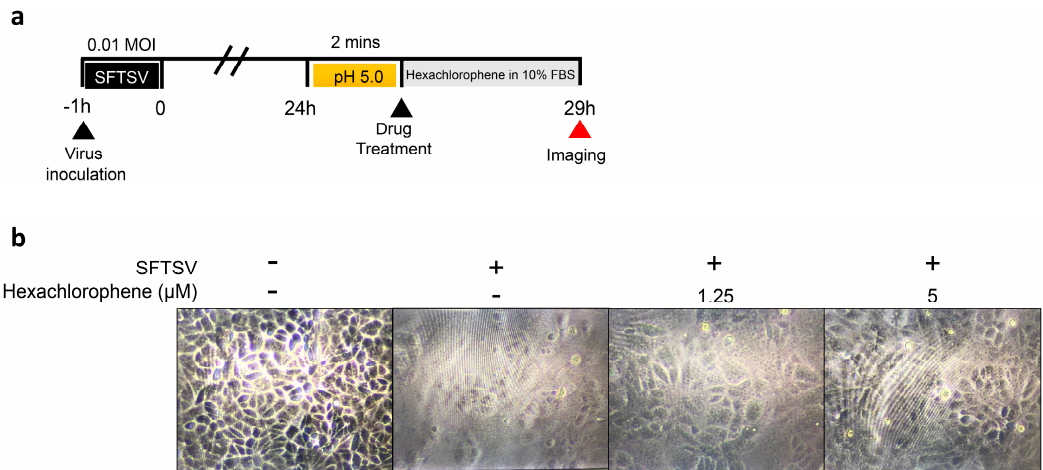
Figure 5. Hexachlorophene inhibits membrane fusion of SFTSV. ( a ) Schematic representation of the experimental procedures. Vero cells were infected with SFTSV (MOI = 0.01) for 1 h. At 24 hpi, the cells were treated with citrate-phosphate buffer adjusted to the pH 5.0 for 2 min, washed, and then replaced with DMEM containing 10% fetal bovine serum (FBS) and different concentrations of hexachlorophene. Syncytium formations were determined by microscopic examination at 5 h after drug addtion. ( b ) Syncytium formation of SFTSV-infected Vero cells with or without hexachlorophene treatment. Mock-infected Vero cells (left) were included as the negative control (magnification 80×).